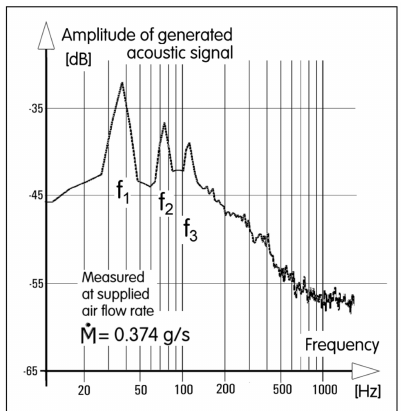
Figure 12. Measured spectrum of generated oscillation at a particular air flow rate.